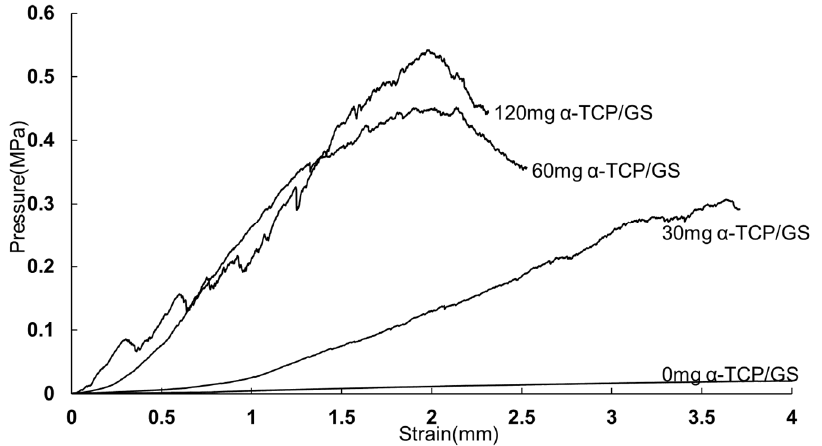
Figure 7. Results of the compression test. The vertical axis represents pressure (unit: MPa). The horizontal axis represents the elapsed time (unit: mm) since detection of compression stress.